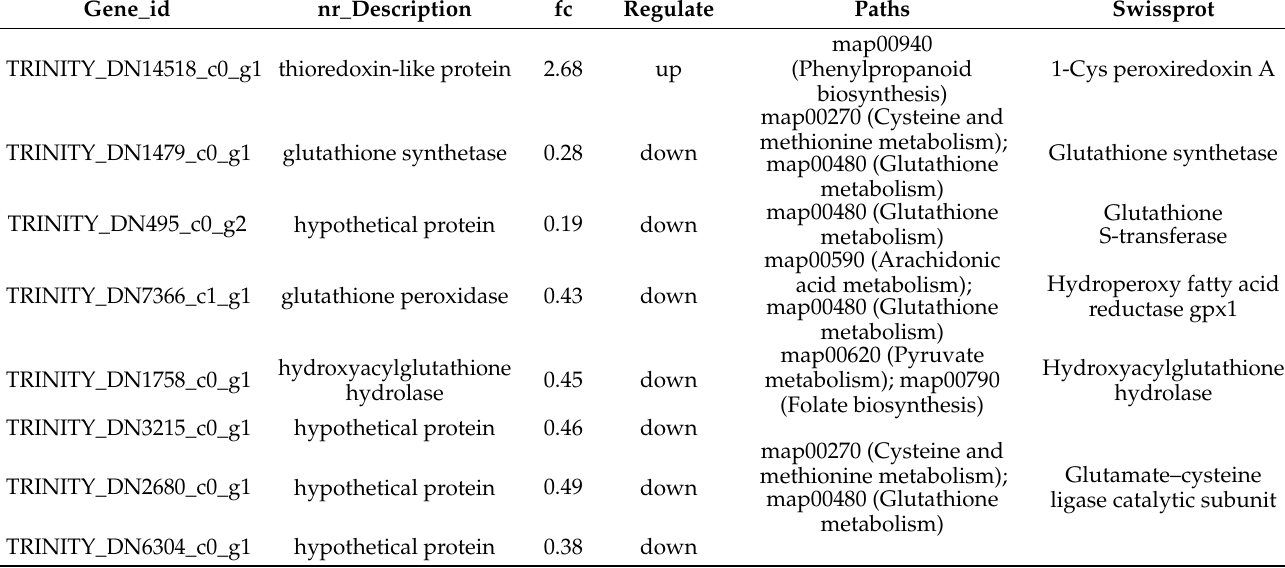
Table 3. DEGs involved in heavy metal stress response in C. fusiformis under Cu 2+ .